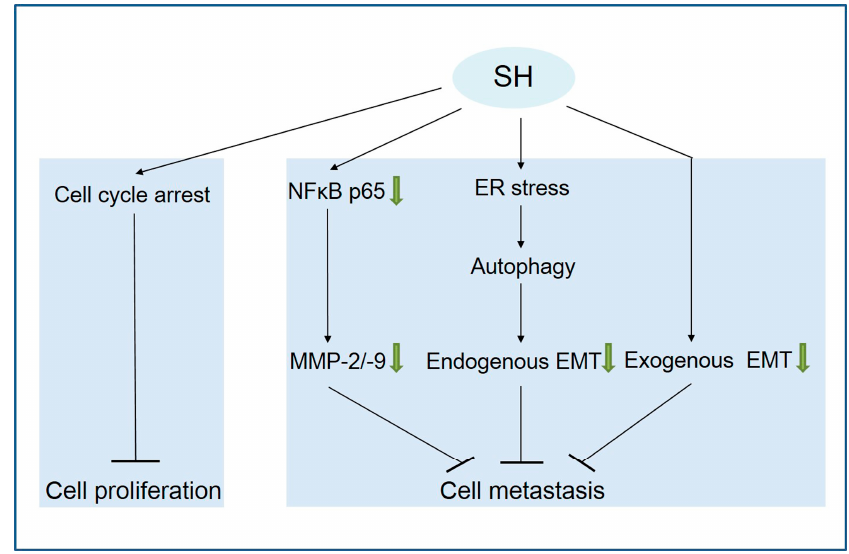
Figure 7. Proposed model delineating the mechanisms of SH in human glioblastoma cells. The green arrow means inhibition; “ ↓ ” means promotion; “ ┴ ” means inhibition.